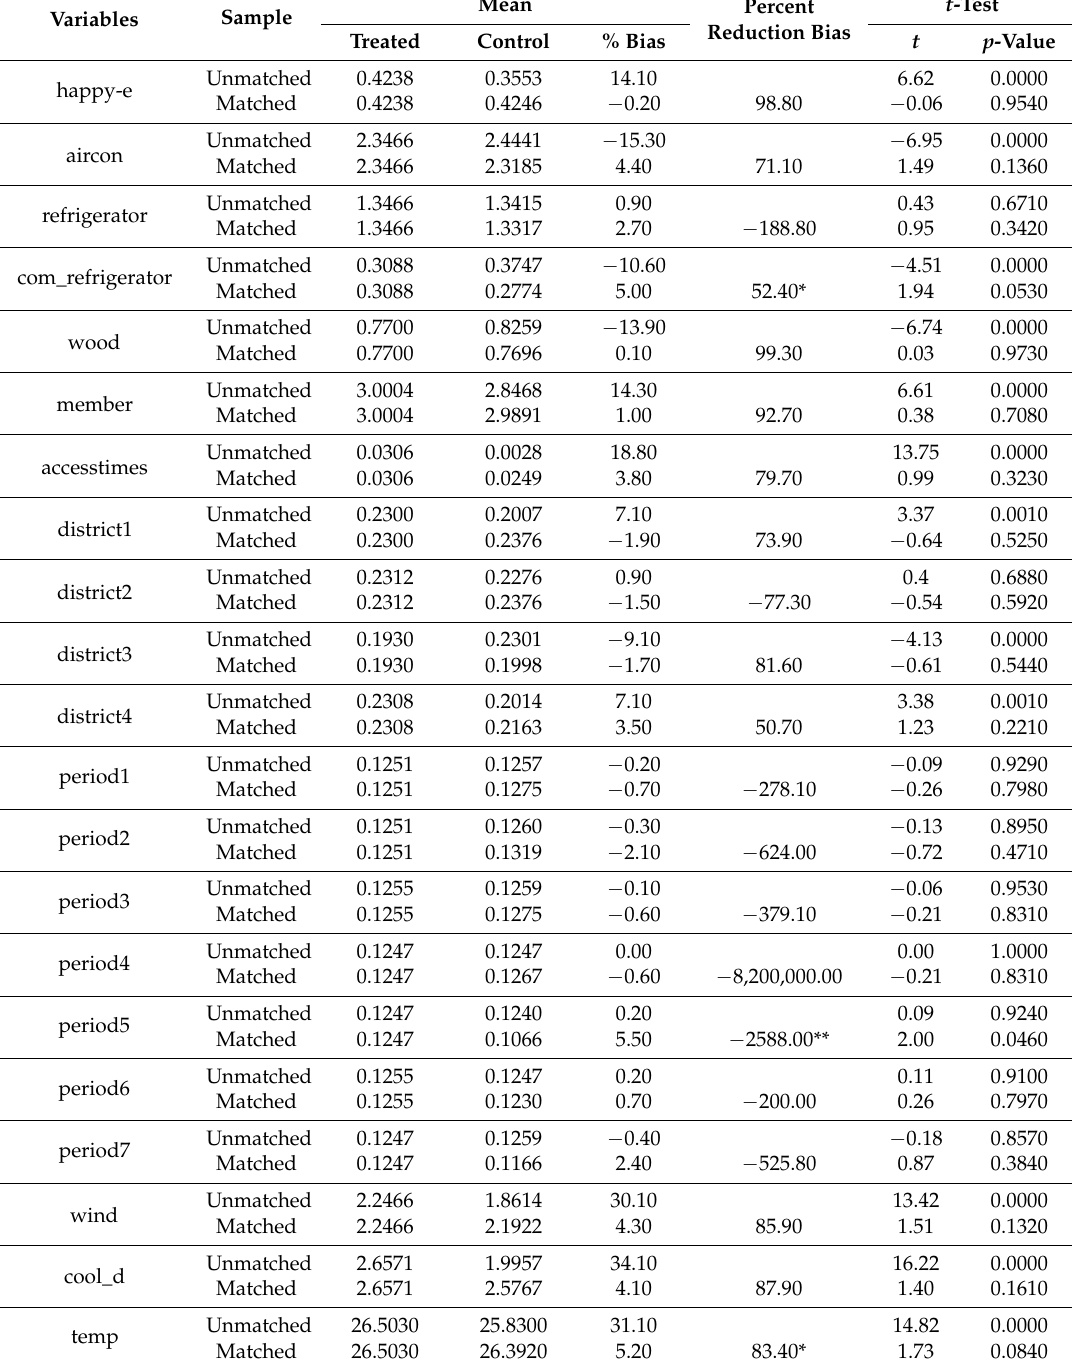
Table A3. Result of balancing test of propensity score model of Dum_40_elas